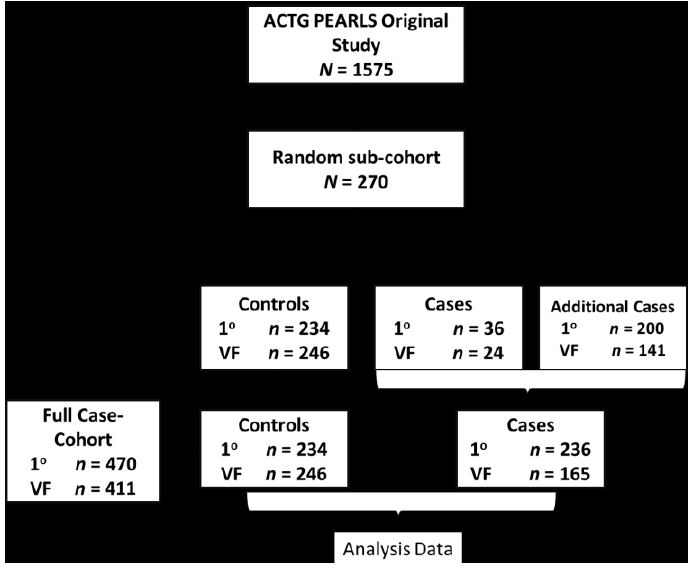
Figure 1. Case-cohort design for primary clinical treatment failure and secondary virologic failure. The case-cohort analysis consisted of the random sub-cohort (random subsample from full cohort) and any additional cases from the full cohort that met the outcome definition. Our primary outcome (1°) was defined as incident WHO stage 3 or 4 event or death ( n = 234 controls and n = 236 cases, total N = 470) within 96 weeks post-ART initiation. Secondary outcomes was virologic failure (VF) ( n = 246 controls and n = 165 cases, total N = 411), defined as 2 successive plasma HIV-1 RNA levels >1000 copies/mL at or after 16 weeks post-ART initiation. The subcohort was used to determine prevalence and characteristics associated with serum selenium deficiency. The full-case cohort (analysis data) was used to study the association of baseline serum selenium concentrations with treatment